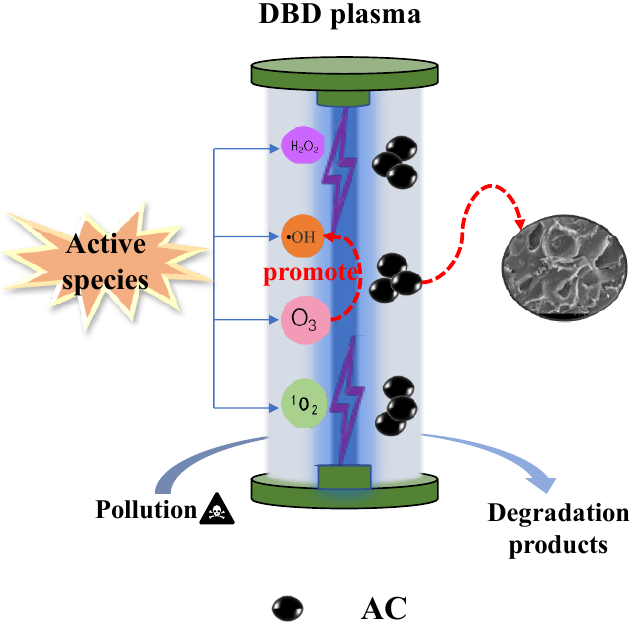
Figure 6. Mechanism of DBD coupled with AC for the degradation of organic pollutants.